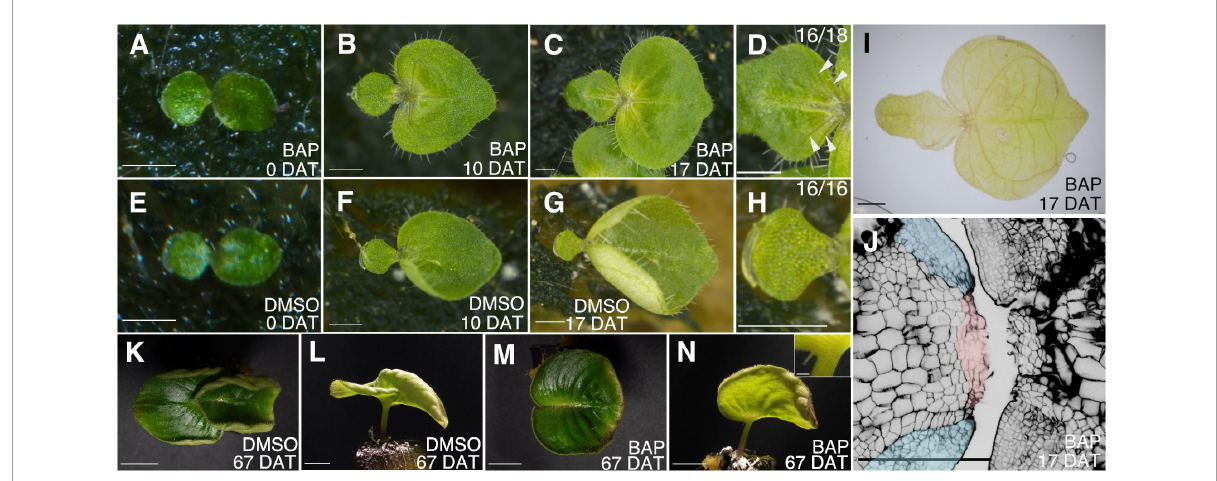
FIGURE5 Application of cytokinin to microcotyledons in the anisocotylous stage induces resumption of the growth of microcotyledons. An individual plant treated with lanolin containing cytokinin (A–D) ; an individual plant treated with lanolin containing DMSO (E–H) . 0 days after treatment (DAT) (A,E) , 10 DAT (B,F) , and 17 DAT (C,D,G,H) . The microcotyledons in (C) and (G) are magnified in (D) and (H) , respectively. The arrowheads in (D) point to lateral veins. (I) An individual treated with lanolin containing cytokinin fixed at 17 DAT. (J) The outline of epidermal and subepidermal cells in the basal part of macro- and microcotyledons in the same individual as (I). The pink and blue shaded areas are the putative GM and BM, respectively, in the microcotyledon resuming growth. (K–N) Individuals treated with cytokinin (K,L) or DMSO (M,N) at 67 DAT. Top views (K,M) and side views (L,N) . The inset in (N) is the magnified view of the microcotyledon of the individual in (N) . Bar = 1 mm in (A–J) , 1 cm in (K–N) , and 100 µ m in the inset of (N)